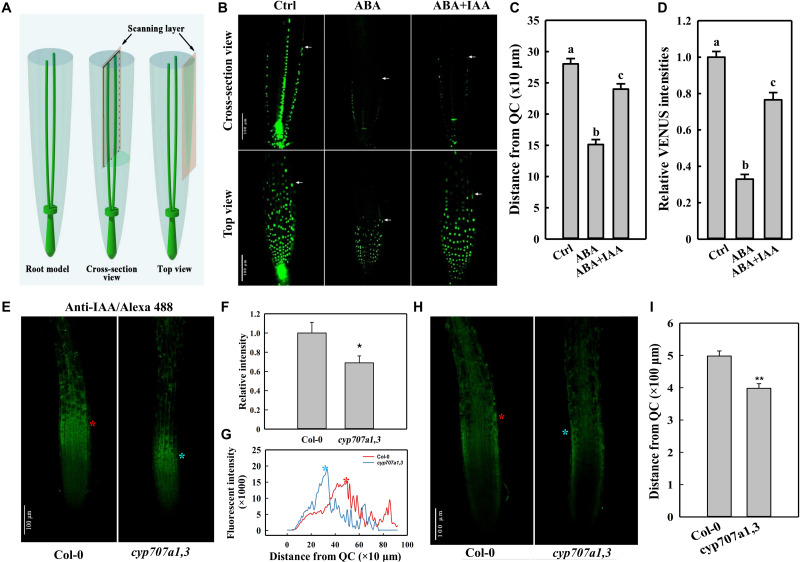
DR5:VENUS signal in the root tip following different treatments, and immunofluorescence of IAA in the root tip of Col-0 and cyp707a1,3. (A) Schematic diagram of the scanning layers of the cross-section (middle panel) and top views (right panel). The cross-section view refers to the image generated by scanning through the middle of the root tip (middle panel). The top view was generated by scanning through the surface of a root. (B) Cross-section and top views of DR5:VENUS signal in the control root tip and those treated with plant hormones. Five-day-old DR5:VENUS seedling were transferred onto control (1/2 MS without hormonal addition), ABA (1/2 MS with 8 μM ABA) or ABA + IAA (1/2 MS with 8 μM ABA together with 5 nM IAA) media. Following a single day of treatment, the seedlings were loaded onto a confocal microscope for imaging. White arrowheads indicate the ends of DR5:VENUS signals. White triangles indicate PIN2-GFP signals in cells of EZ. (C) Coverage of SAT as reflected by the distance from the end of the epidermal DR5:VENUS signal (panel b, white arrowheads) to the QC. Measurements were conducted according to the cross-section view in the panel (B). (D) Relative epidermal DR5:VENUS intensities following the same treatments as in panel (B). Fluorescence intensities were normalized to the control. Measurements were conducted according to the top view in panel (B). (E) Top view of the anti-IAA/Alexa Fluor 488 (IAA/Alexa 488) signal in Col-0 and cyp707a1,3. Primary roots (PRs) of 5-day-old Col-0 and cyp707a1,3 seedlings were immunodetected using anti-IAA/Alexa Fluor 488. Fluorescence intensities were normalized to Col-0. (F) Total intensity of IAA/Alexa 488 in the root tip of Col-0 and cyp707a1,3. (G) Vertical profiles of IAA/Alexa 488 signal in the epidermis. Line profiles were generated from the epidermal IAA/Alexa 488 signal as shown in panel (E), according to its fluorescence intensity along the vertical direction of the root. (H) Cross-section view of IAA/Alexa 488 in the root tip. The stars (red and blue) in this panel, as well as those in panels (E,G), indicate the intensity peak of the IAA/Alexa 488 signal in Col-0 (red) and cyp707a1,3 (blue). n = 15. (I) Coverage of acropetal auxin flux (AAF) evaluated by the distance from the intensity peak of the epidermal IAA/Alexa 488 signal [panel (H), red and blue stars] to QC. Measurements were performed according to the cross-section view. For the histograms shown in panels (C,D), each bar data represents the mean of 30 independent measurements ± SE. * and ** represent p < 0.05 and p < 0.01 respectively.